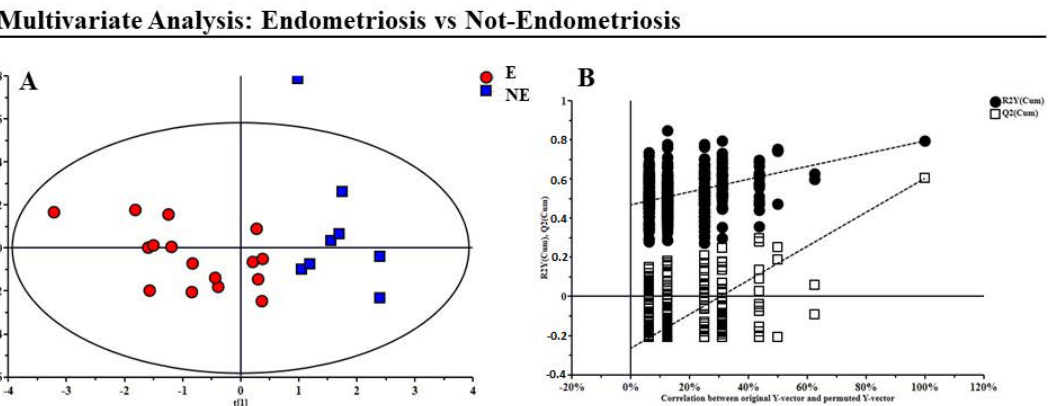
Figure 1. GC − MS analysis of serum Endometriosis (E) and Not − Endometriosis (NE) samples. ( A ) Supervised model PLS − DA score plot from E and NE samples analyzed with the GC − MS; ( B ) Validation of the model via permutation test ( n = 400).